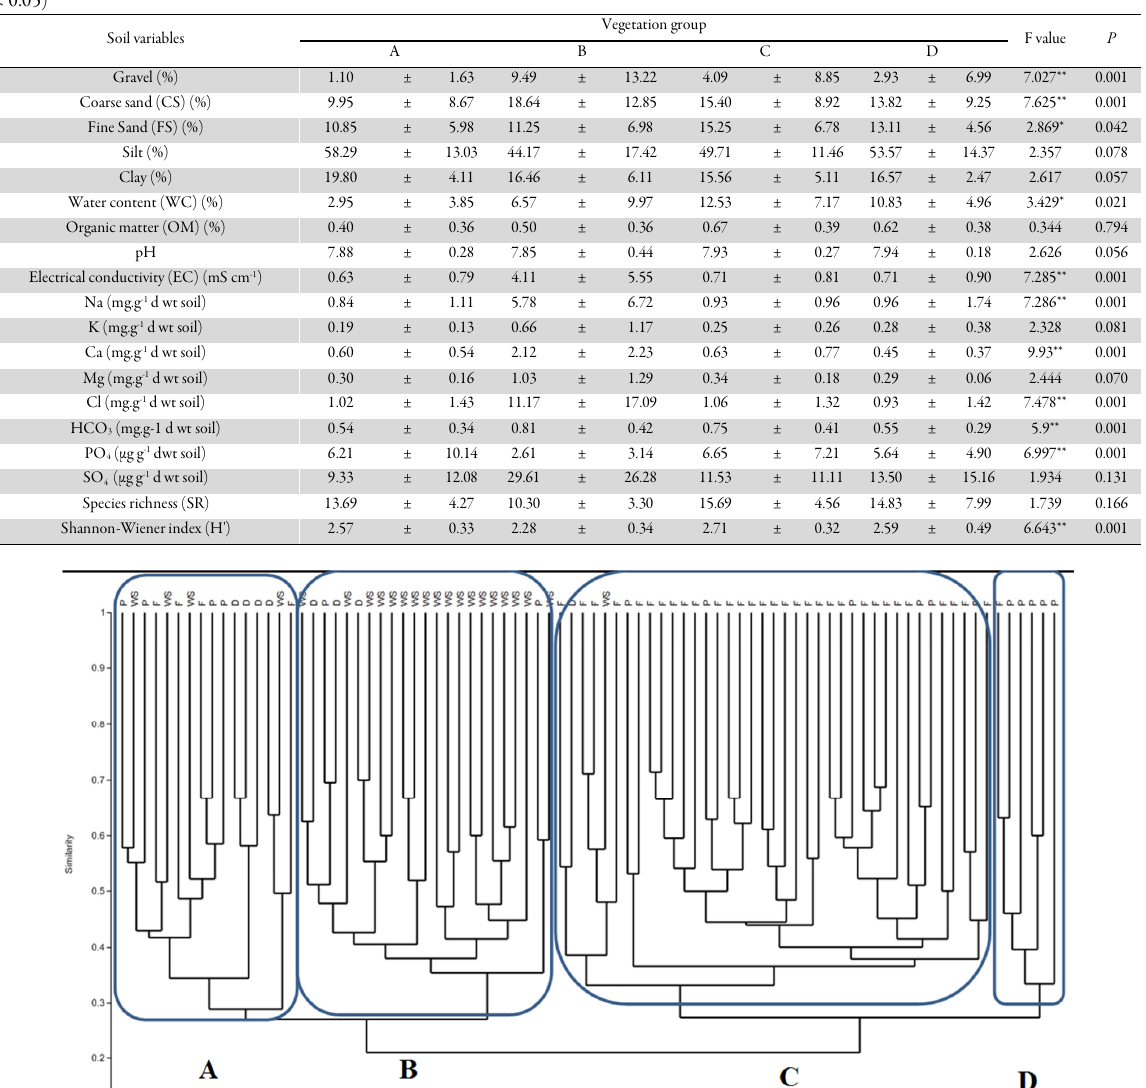
Fig. 2.The relationship between the four vegetation groups (A-D) generated after application of cluster analysis; P = Palm orchards, F = Farmlands, S = Saline lands, W = Waste lands, D = Desert